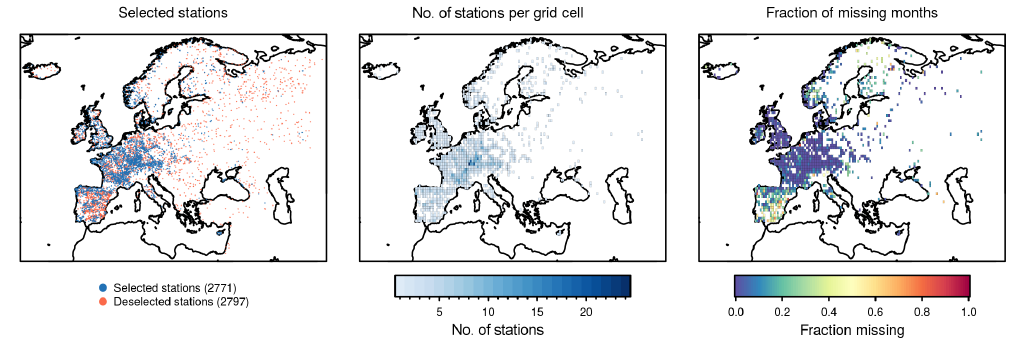
Figure 5. Assigning stations to the 0.5 ◦ × 0.5 ◦ grid cells defined by the E-OBS data. Left: selected stations fulfilling all selection criteria (see Sect. 4.6). Centre: number of stations per grid cell. Right: fraction of months with no or insufficient data.